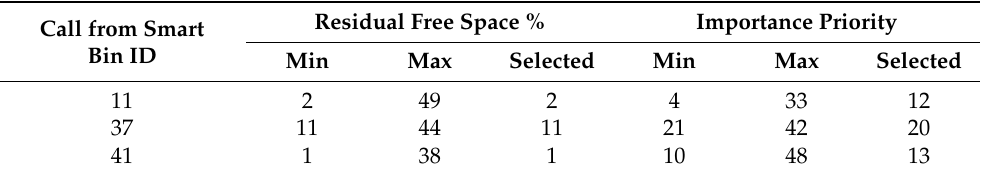
Table 3. Residual free space R fs , and importance priority value IPv